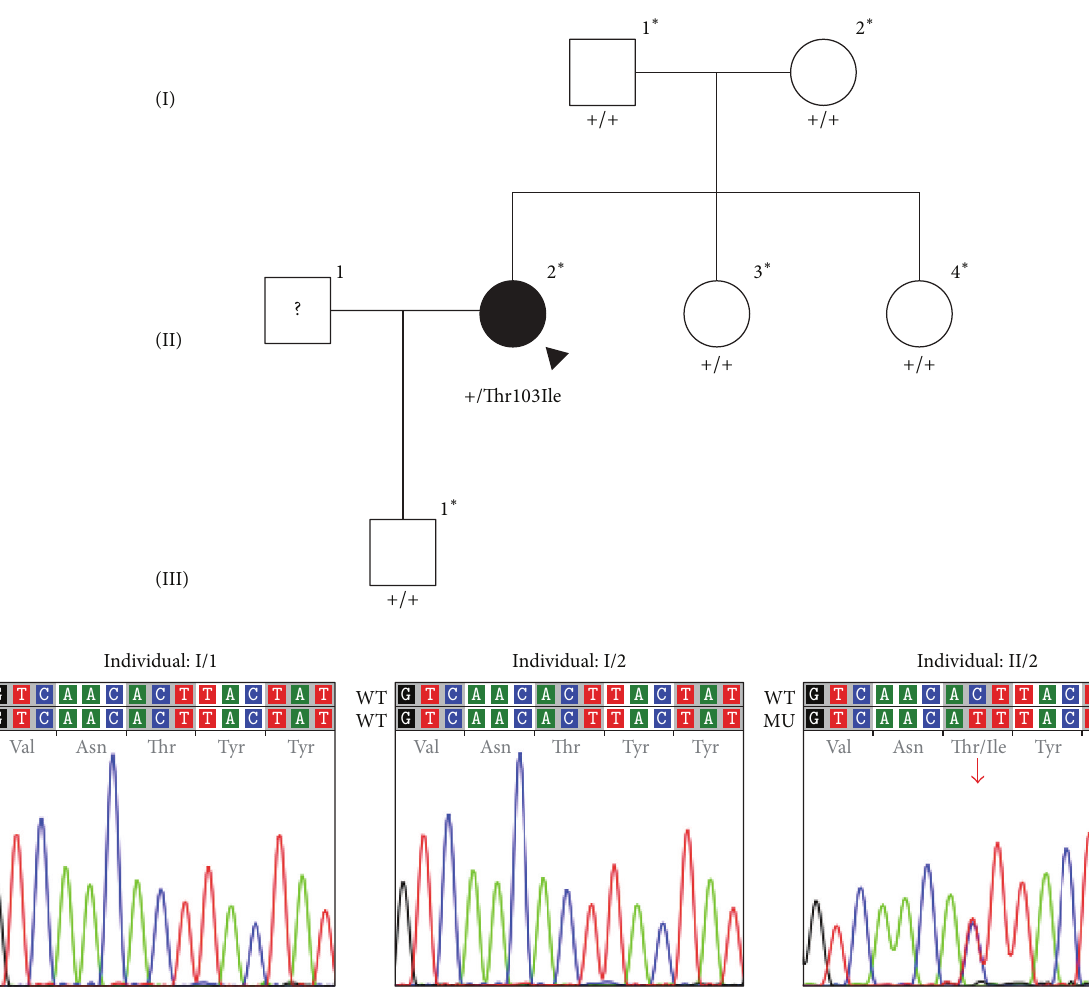
Figure 1: Pedigree of family with Schnyder corneal dystrophy. Filled symbols represent affected individuals and unfilled symbols represent unaffected individuals. Question marks indicate individuals of unknown affected status. The proband is designated with a black arrowhead. Asterisks indicate individuals in whom UBIAD1 screening was performed; below these symbols, the results are given as wild type (+) or the identified mutation is shown. Chromatograms demonstrate the results of sequencing UBIAD1 in the parents of the proband and the proband, in whom the identified heterozygous c.308C > T missense mutation is indicated with a red